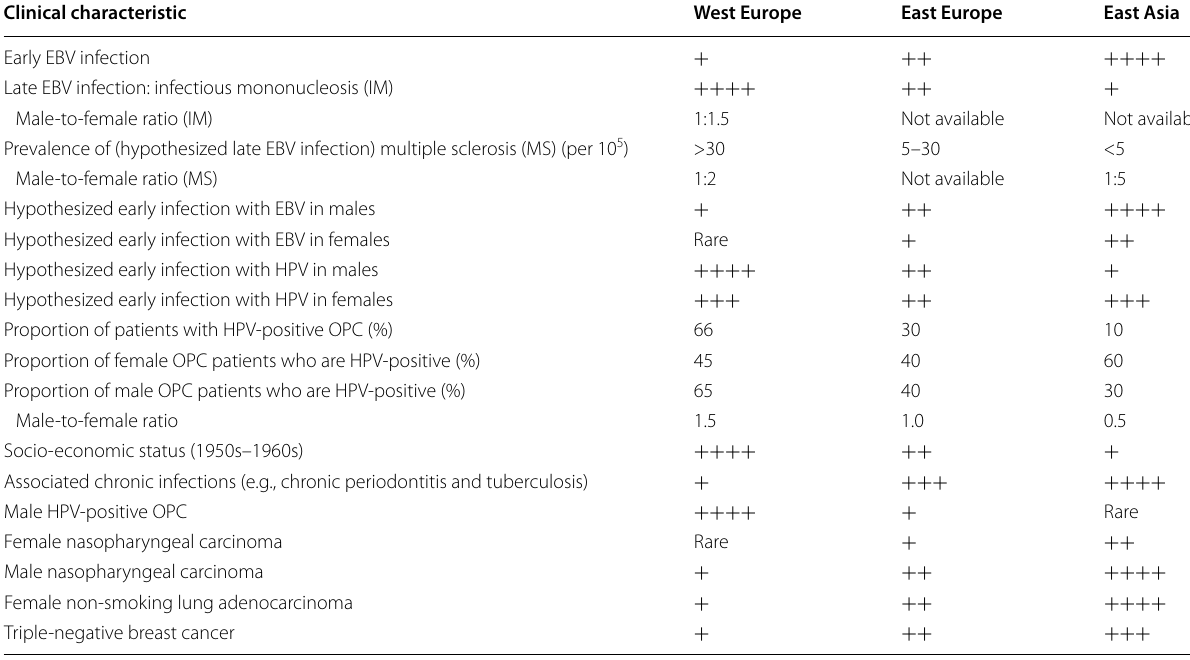
EBV Epstein–Barr virus, HPV human papilloma virus, OPC oropharyngeal carcinoma